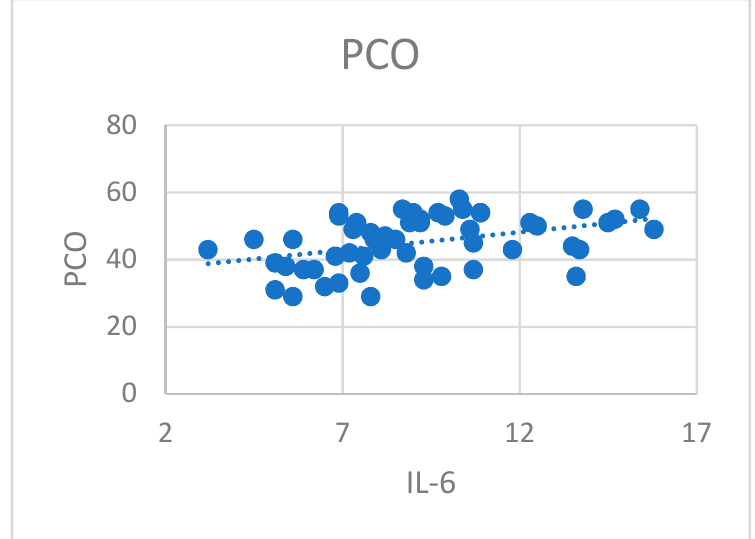
Figure A3. PCO and IL-6.